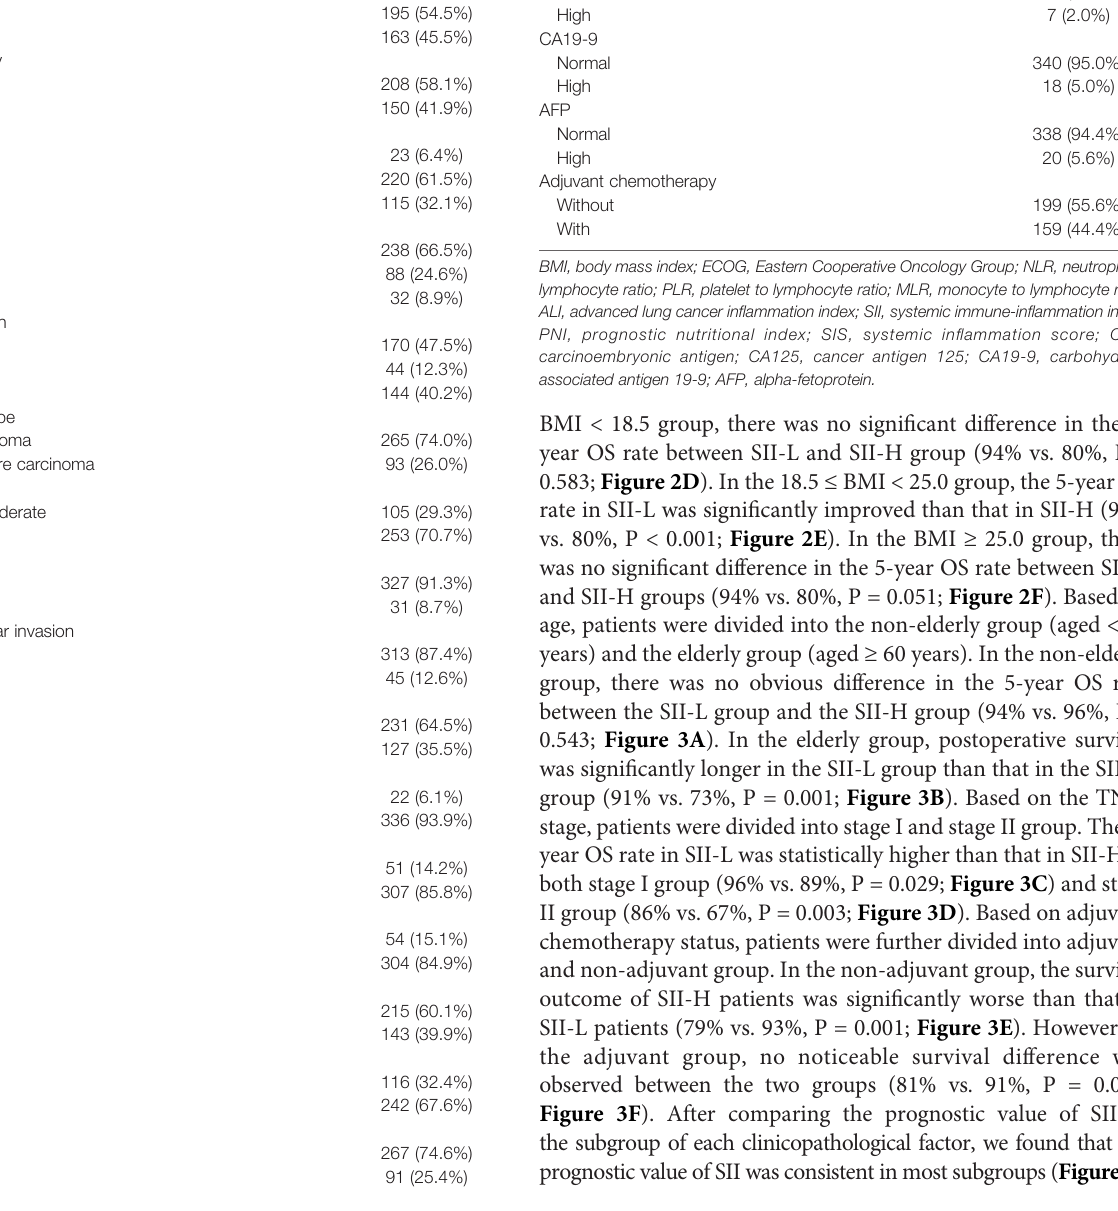
Figure 3F ). After comparing the prognostic value of SII in prognostic value of SII was consistent in most subgroups ( Figure 4 ).